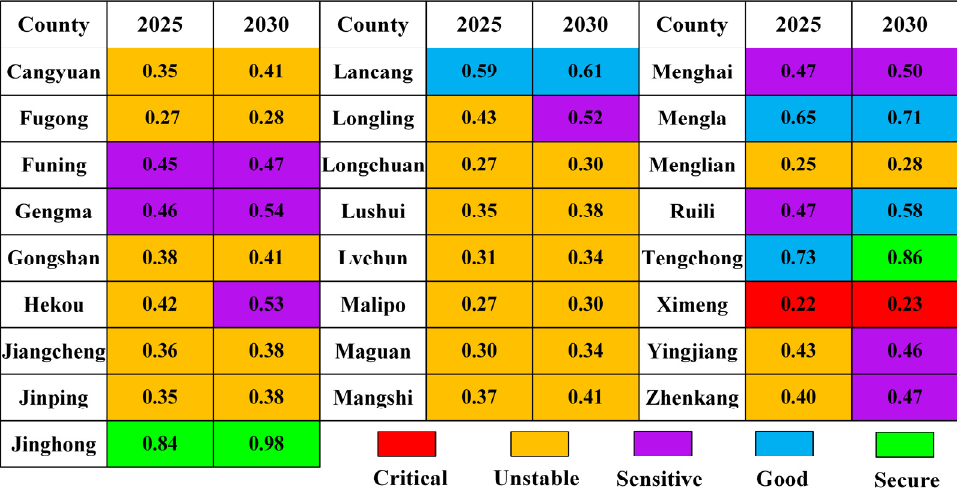
Figure 8. Prediction of the ecological security in 25 border counties of Yunnan Province, China in 2025 and 2030.